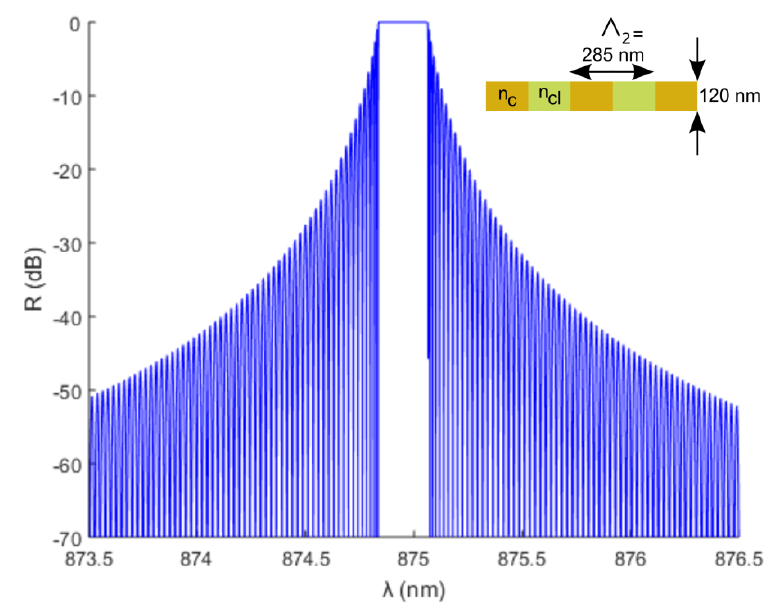
Figure 2. Calculated reflection spectrum for grating sensor 2 with dimensions as shown in the inset. Table 1. The calculated Bragg wavelength and 3 dB bandwidth for the three gratings with different pitch. The depth, the length and the duty cycle are the same for all gratings.